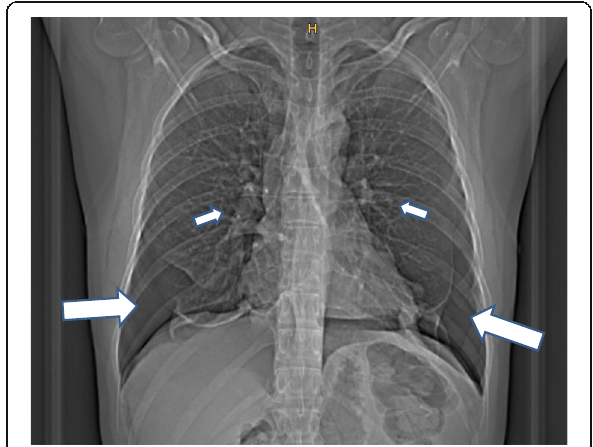
Fig. 2 Chest computed tomography scan from the index patient. Bilateral pneumothorax (large arrows) and lung bullae (small arrows) are indicated. The pneumothorax is mostly localized in the basal parts of the chest cavity due to previous pleurodesis